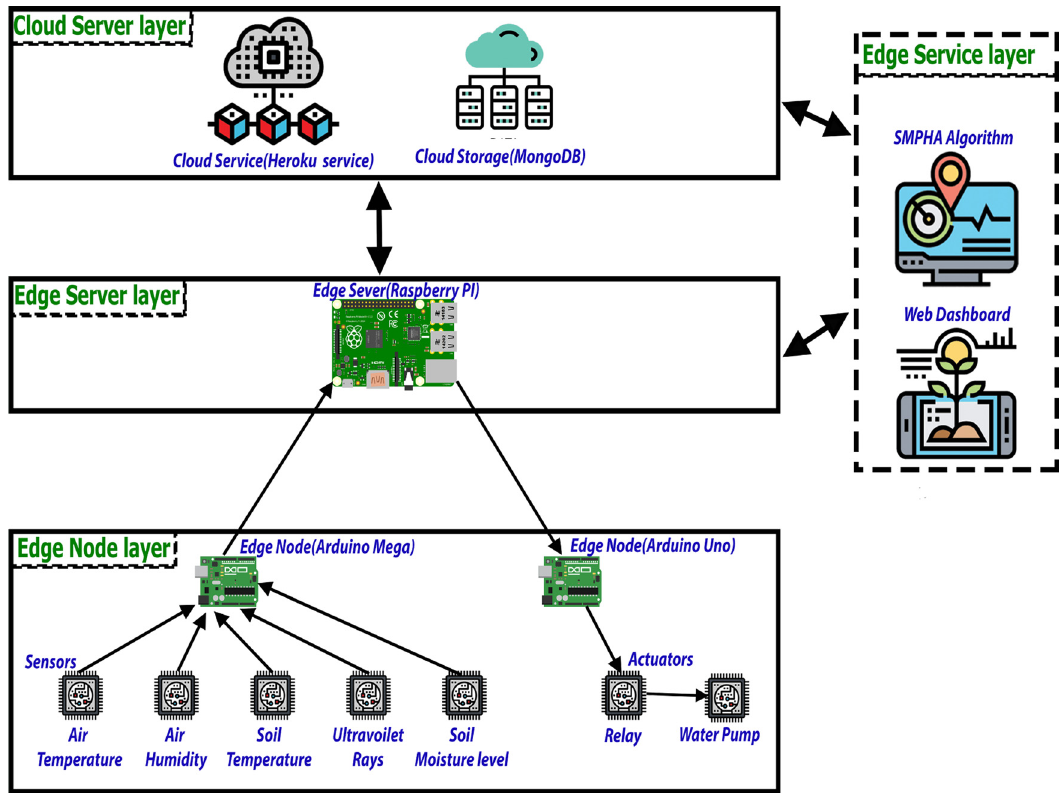
Figure 2: Components of the proposed system.